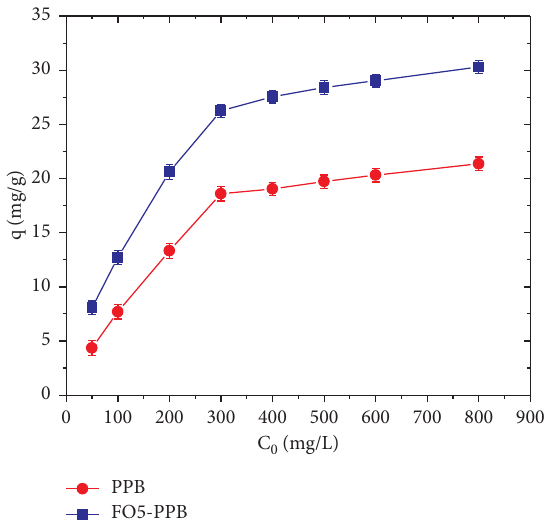
Figure 9: The effects of initial concentration on adsorption by PPB and FO5-PPB. Experimental conditions: pH: 3; adsorbent dose: 2 g/ L; contact time: 60